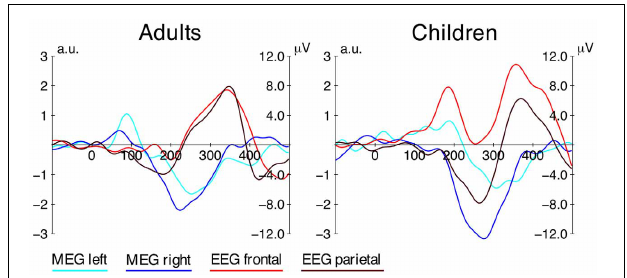
FIGURE 5 | Grand average difference waves from MEG and EEG. Difference waves for both age groups (distractor-minus-standard) from the MEG source localization data (left and right ROI) and frontal (F3, Fz, F4) and parietal (P3, Pz, P4) electrode clusters from the EEG data. The left axis shows the amplitude for the MEG data, the right axis shows the amplitude for the EEG data (note that the y-axis is not inverted as opposed to other graphs presented